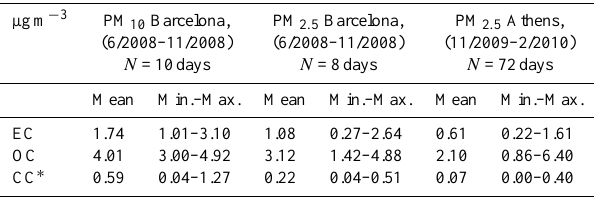
Table 3. OC, EC and CC mean daily concentrations [µgm − 3 ], measured at Barcelona site during February–August 2008 and at Athens site during October 2009–February 2010 (semi-continuous measurements 3h).